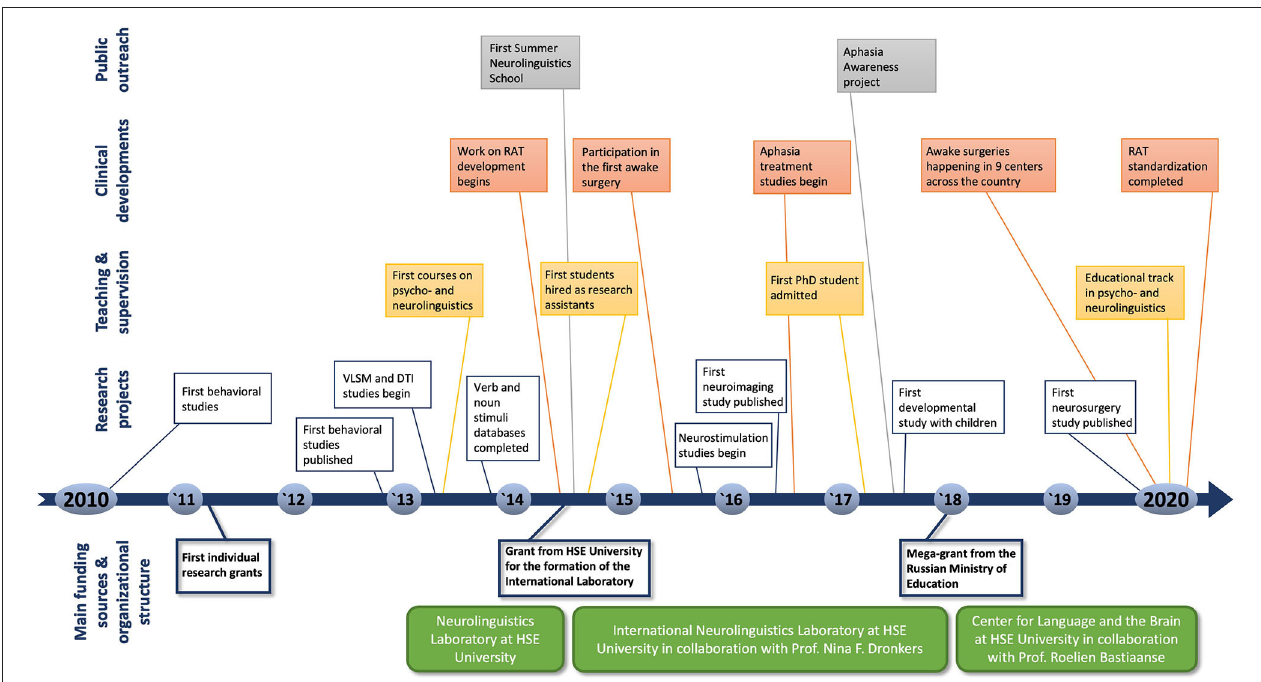
FIGURE 1 | Timeline representing the advancements and contributions made by our team to the field of neurolinguistics in Russia in 2010–2020, highlighting the main milestones and accomplishments in research, clinical work, teaching and supervision, and public outreach